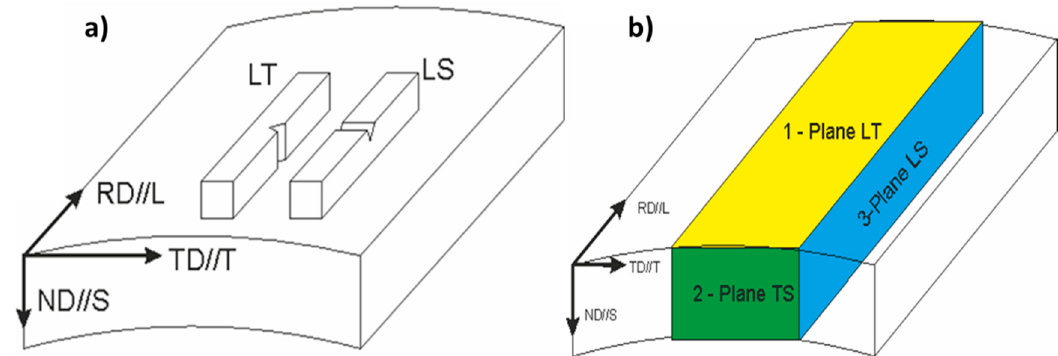
Figure 1. ( a ) Scheme indicating the position of the notch in respect to the rolling direction material; and ( b ) Scheme of sectioned samples for Electron Backscattering Diffraction (EBSD) measurements, respectively.